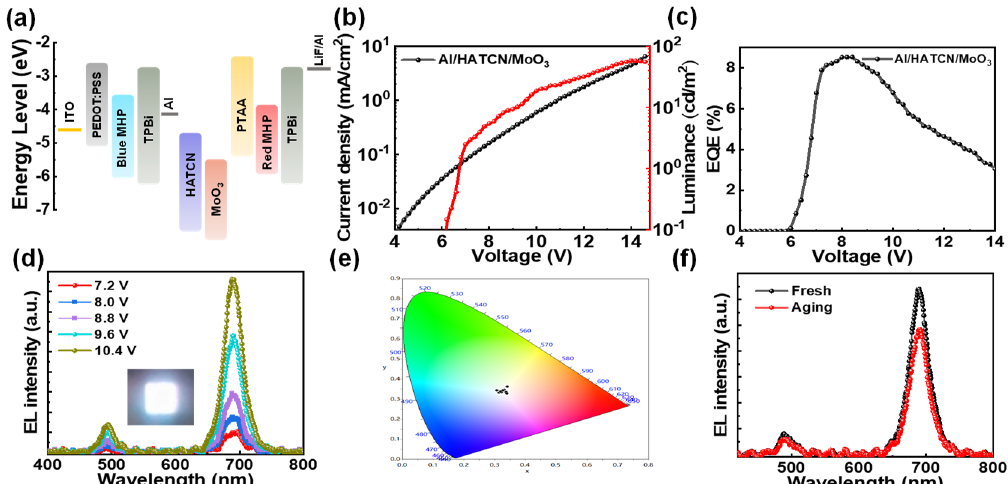
Figure 4. ( a ) Energy level diagram of tandem PeLEDs. ( b ) Current density and luminance versus voltage plots of tandem PeLEDs. ( c ) EQ versus voltage plots of tandem PeLEDs. ( d ) EL spectra of tandem PeLEDs at different biases. Inset of panel ( d ): a photograph of the white PeLED. ( e ) CIE coordinates. Each black dot corresponds to the spectra in ( d ). ( f ) The EL spectra of a fresh and an aging device.